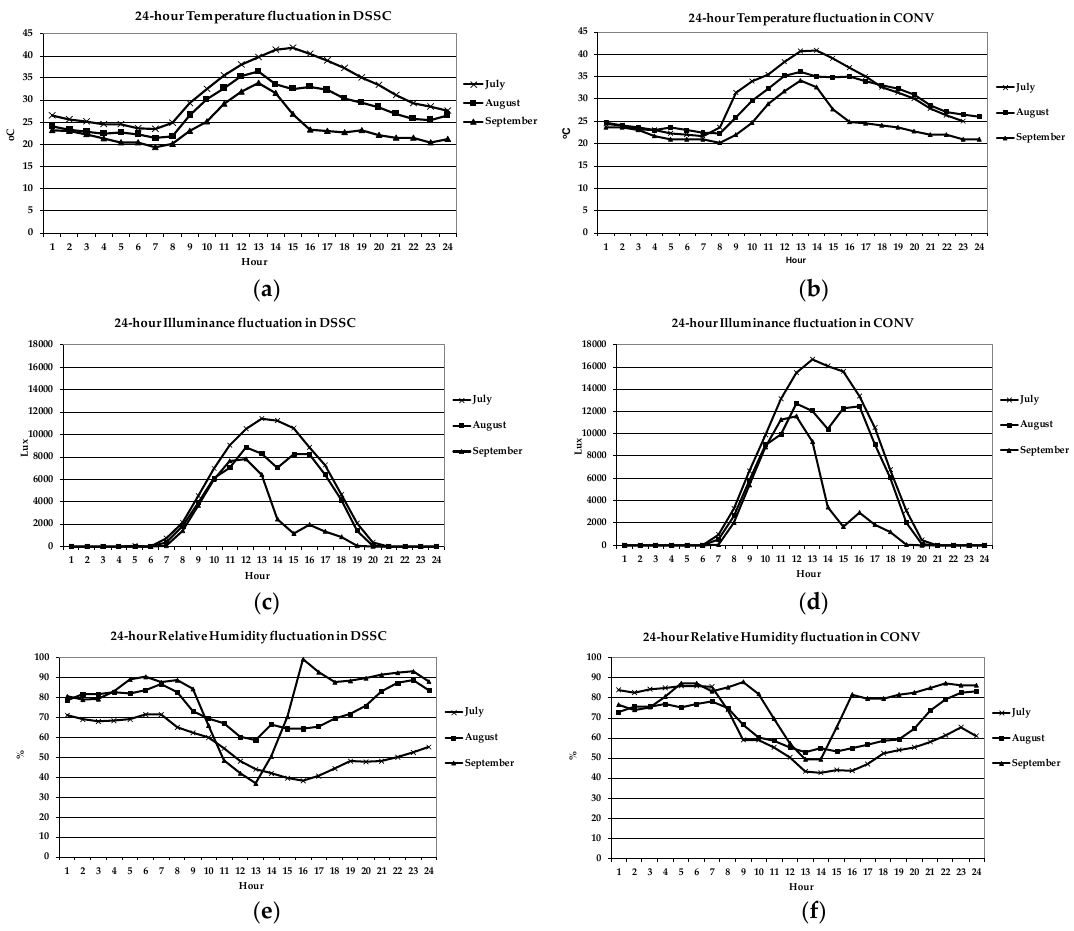
Figure 3. Air temperature, illuminance, and relative humidity inside the two greenhouses [CONV (Conventional), DSSC (Dye-Sensitized Solar Cell)]: ( a ) Air temperature (DSSC); ( b ) air temperature (CONV), ( c ) illuminance (DSSC); ( d ) illuminance (CONV); ( e ) relative humidity (DSSC); and ( f ) relative humidity (CONV).